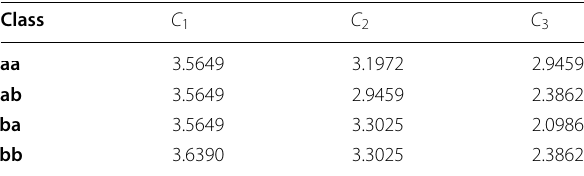
Table 4 The trained model p ( C | T ) with equivalent of TF‑IDF vector tfidf ( S , C ) for the training data. S = { aa , ab , ba , bb } is the SFA words and C = { C 1 , C 2 , C 3 } is three states of the fan